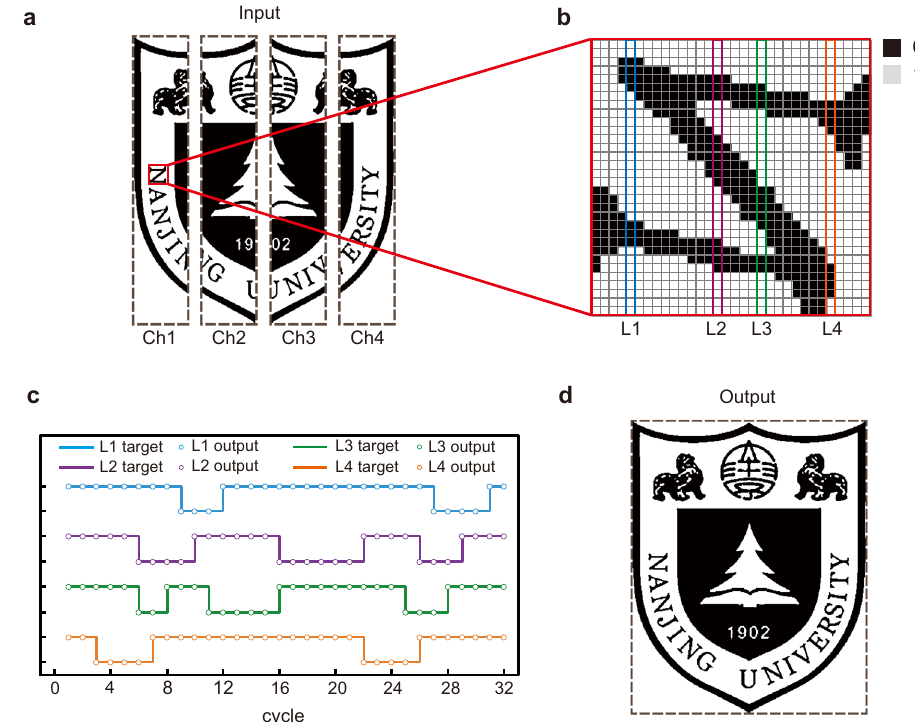
c Thetargetandoutputdatastreamsoffourlinesin b ,markedbyL1,L2,L3,andL4. d The output image reconstructed from four data streams received in real-time by four sensors located at focal points. Permissions for use of the Nanjing University logo in this fi gure were obtained from Nanjing University. All rights reserved.